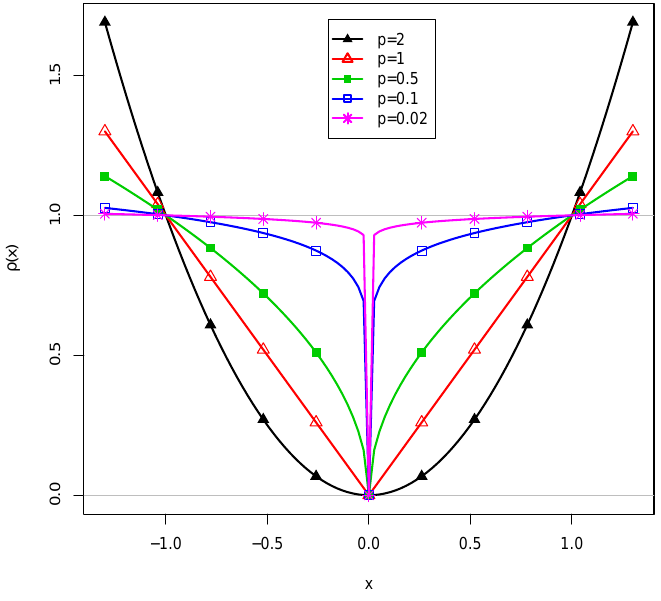
p for different values of p x | |